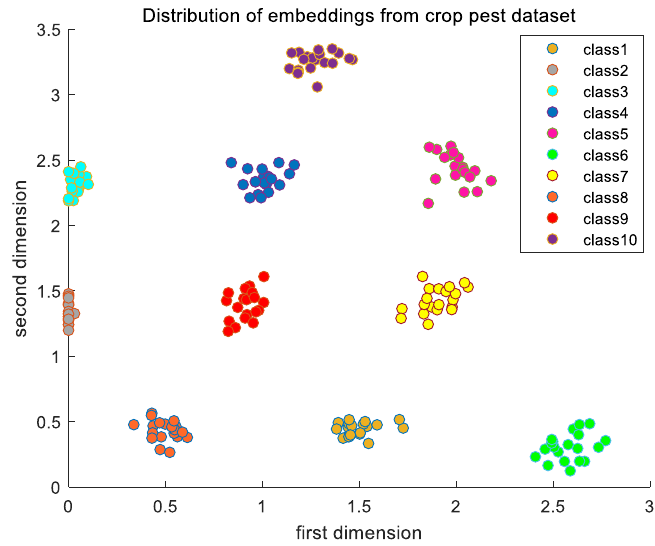
Figure 9. The distribution of embeddings from the crop pest dataset.